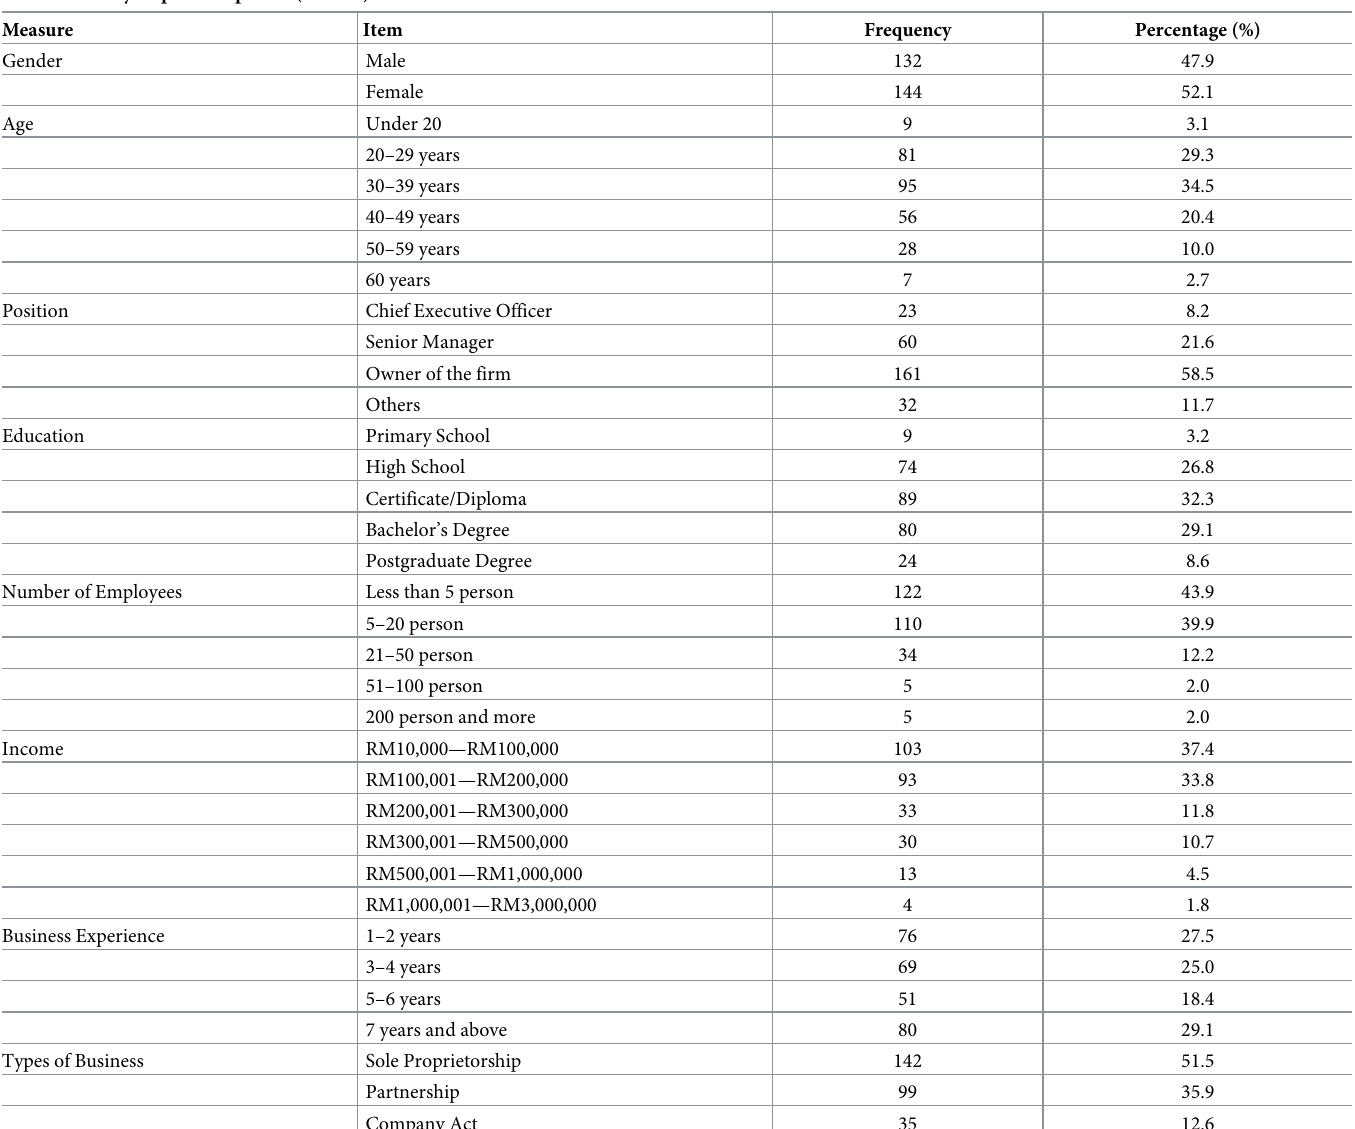
Table 1. Survey respondent profile (n =